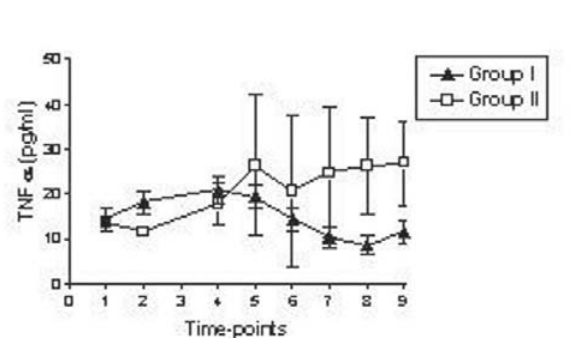
Fig. 6 - TNF-á values over time. Group 1 - no ultrafiltration; Group II - with ultrafiltration. * statistically